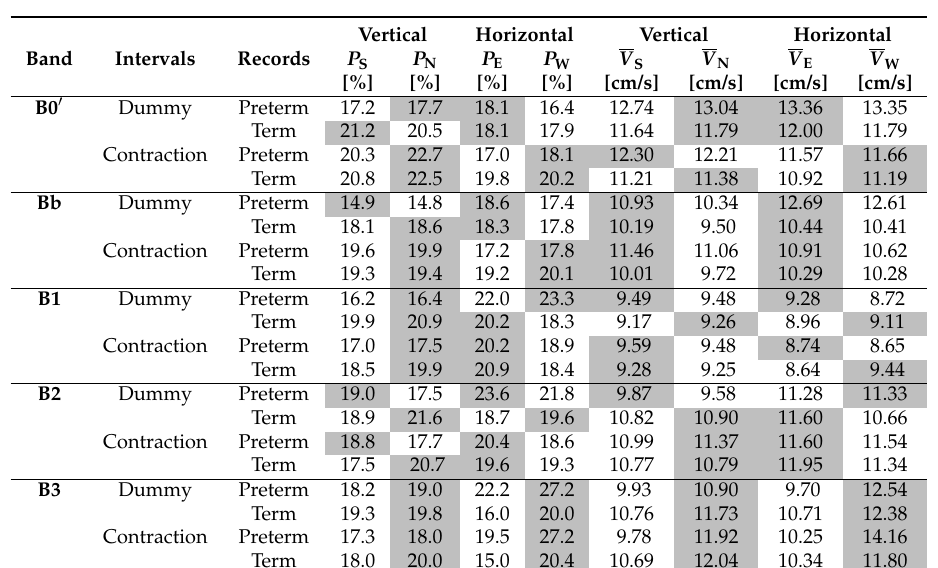
Table 3. The percentages of velocity vectors, P S (south), P N (north), P E (east), and P W (west), and average conduction velocity amplitudes, V S (south), V N (north), V E (east), and V W (west), by sector in the vertical and horizontal directions. All statistics are aggregate average statistics over all dummy and contraction intervals. The highest percentage per vertical (or per horizontal) direction and the highest average conduction velocity per vertical (or horizontal) direction is shaded in